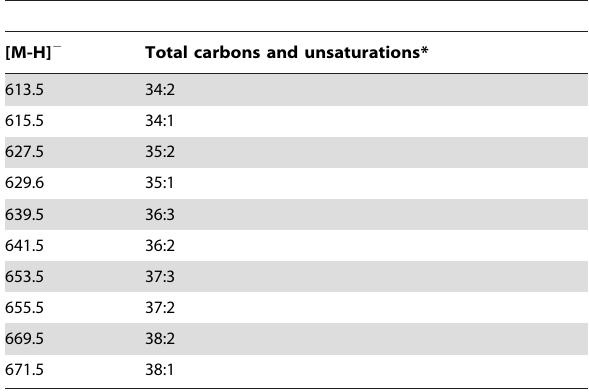
Table 5. Phosphonosphingolipid species identified in A. pallida lipid